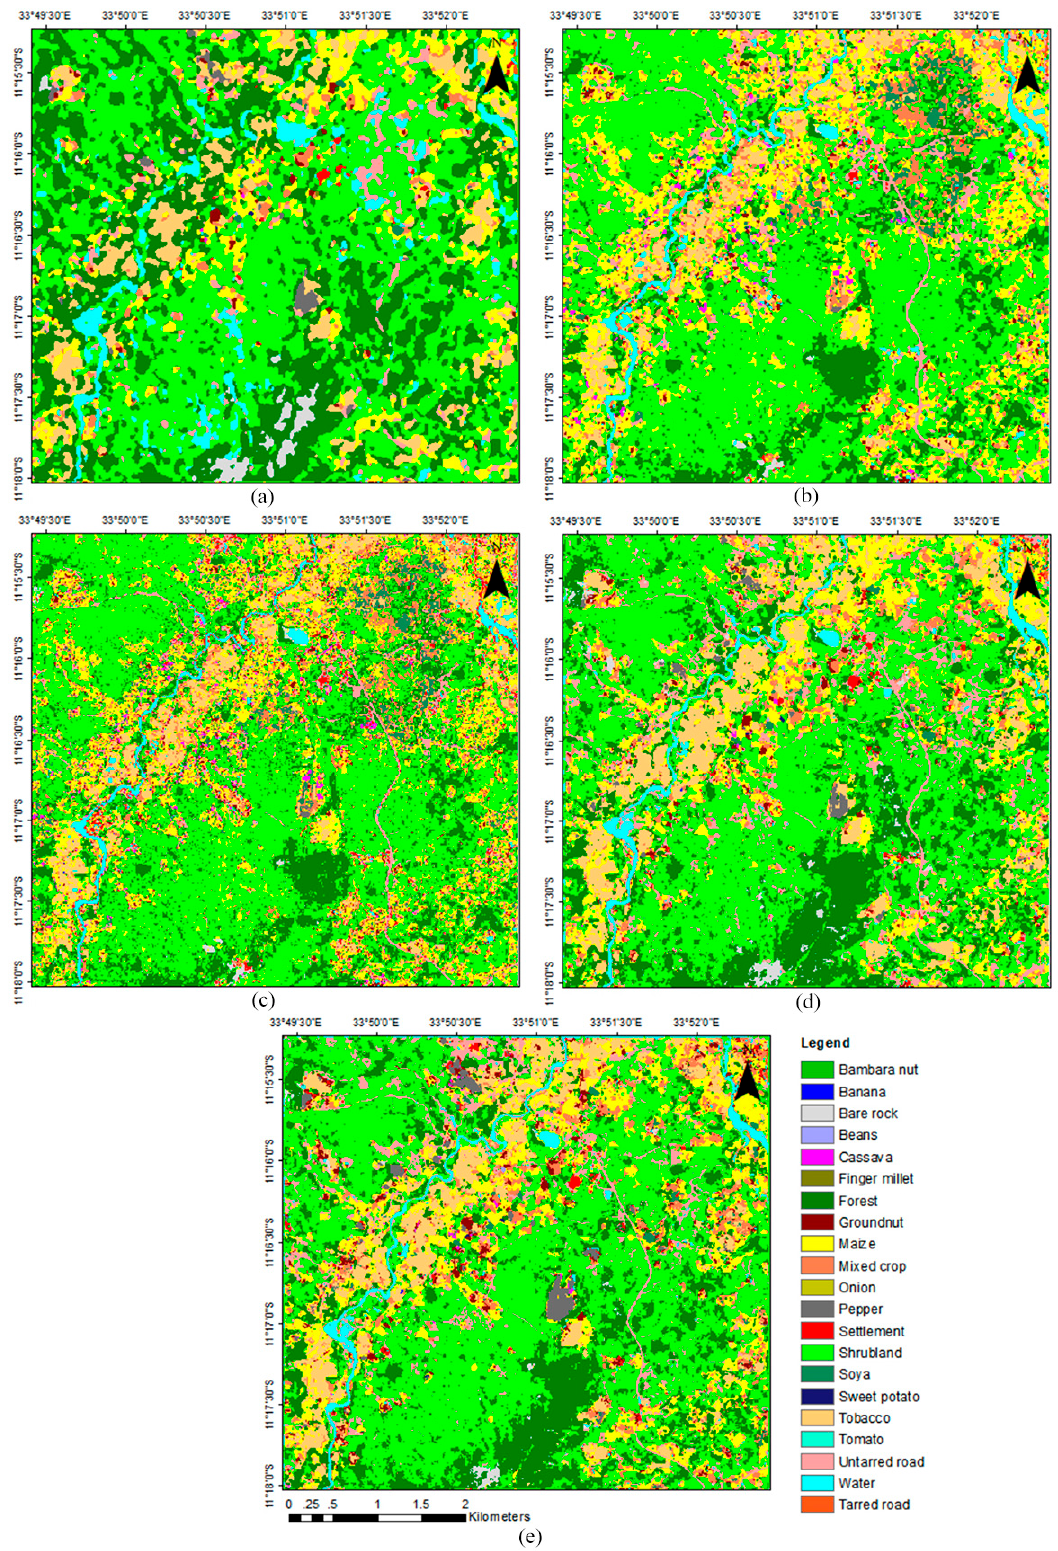
Figure 6. Classification results of Thimalala area ( a ) using Sentinel-1 only; ( b ) using Sentinel-2 only; ( c ) using the fused image of Sentinel-2 and PlanetScope; ( d ) using the fused image and Sentinel-1 C 2 matrix; ( e ) using the fused image, Sentinel-1 C 2 matrix, and H/ α polarimetric decomposition.